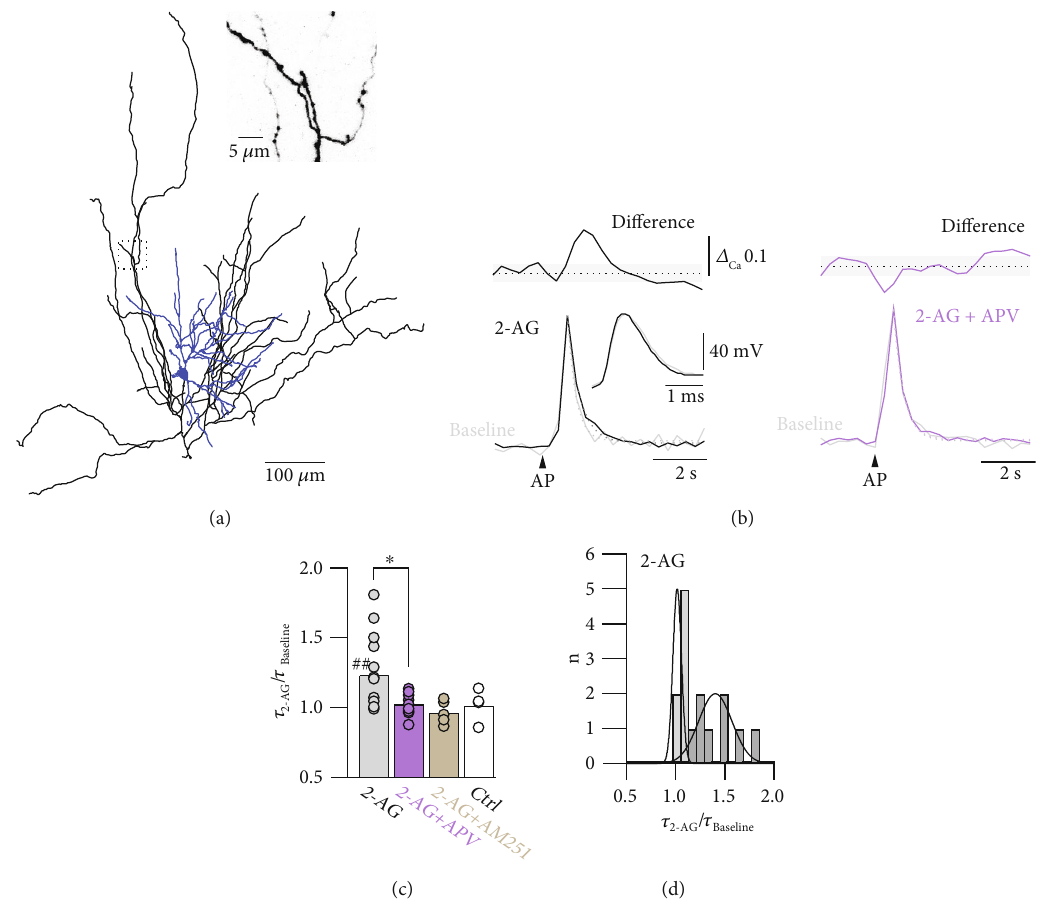
Figure 5: 2-AG broadens AP-evoked Ca 2+ transients in L4 axons. (a) Neurolucida reconstruction of a spiny stellate neuron. Dendrites are represented in blue and the axonal arborization in black. Inset, two-photon fl uorescence image of the axon segment imaged in L2/3 indicated by the dashed box. (b) Left, averaged and normalized AP-evoked Ca 2+ transients during baseline (grey) and after bath application of 2-AG (black). Upper trace represents the di ff erence between the baseline and 2-AG Ca 2+ transients. Dashed line indicates zero, and light-shaded area indicates the baseline noise level ( ± SD). Dashed lines represent single exponential fi ts to the decay of the Ca 2+ transients. There is an apparent di ff erence between the two transients. Inset shows somatic APs before and after bath application of 2-AG. Right, experiment in which the NMDAR-blocker APV was present in the bath. No di ff erence between the two transients was observed in this condition. (c) Normalized decay time constant in the presence of 2-AG for di ff erent conditions. 2-AG signi fi cantly broadened the Ca 2+ transients ( n = 15 ). ## p < 0 : 01 for the e ff ect of time on τ by paired Student ’ s t -test. In contrast, no broadening was observed in the presence of APV ( n = 11 ), AM251 ( n = 5 ), or in control conditions without application of any drug (Ctrl, n = 4 ). APV had a signi fi cant e ff ect on τ in the presence of 2-AG. ∗ p < 0 : 05 by one-way ANOVA. All data are represented as mean ± SEM . (d) Distribution of normalized decay time constants in the presence of 2-AG. Solid black lines represent Gaussian fi ts to the subsets that showed either no (light grey) or signi fi cant (dark grey) broadening of the Ca 2+